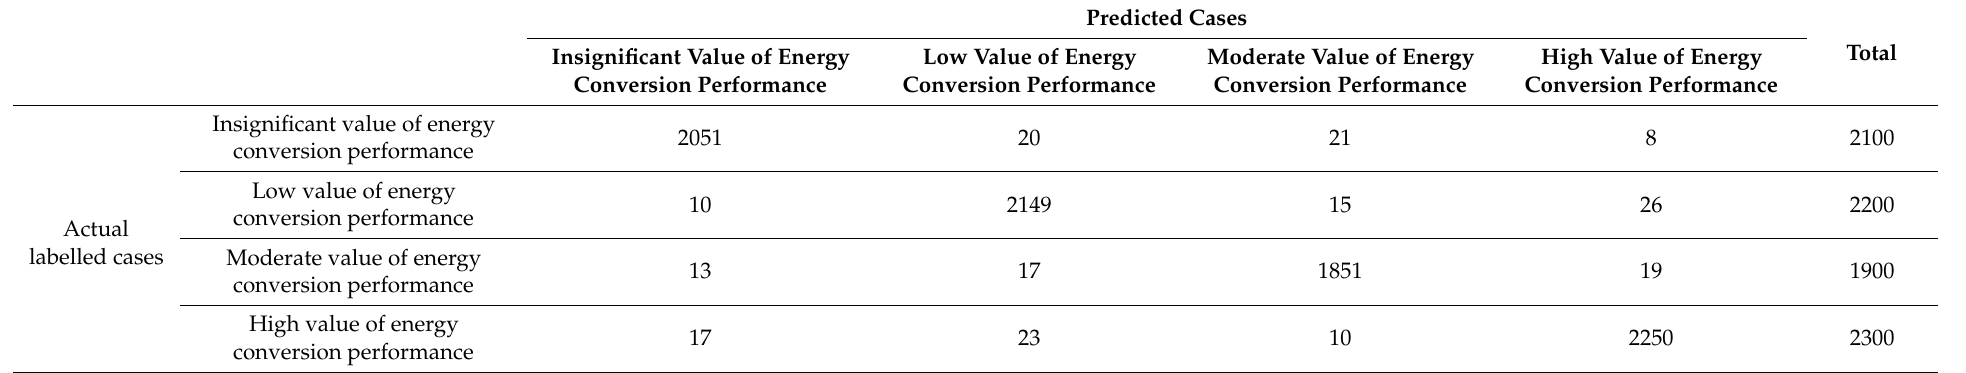
Table 7. Confusion matrices for value of energy conversion performance with the transfer